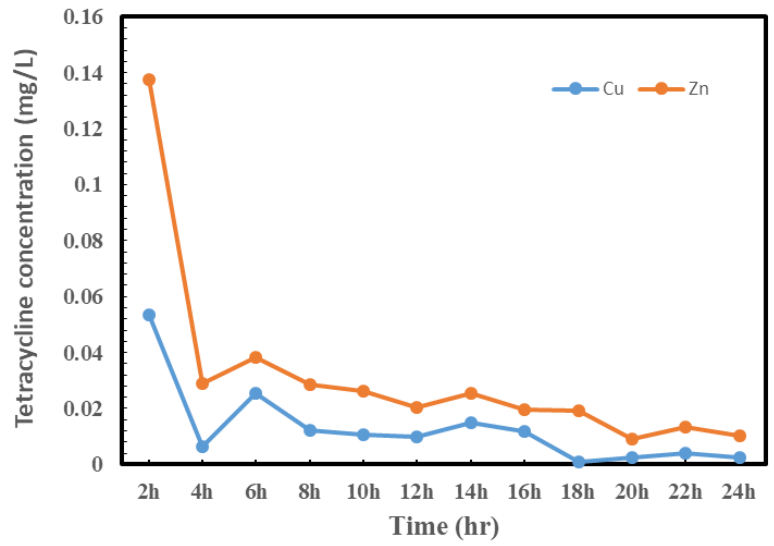
Figure 8. Release study of TC from CMC-Cu-MEL and CMC-Zn-MEL.